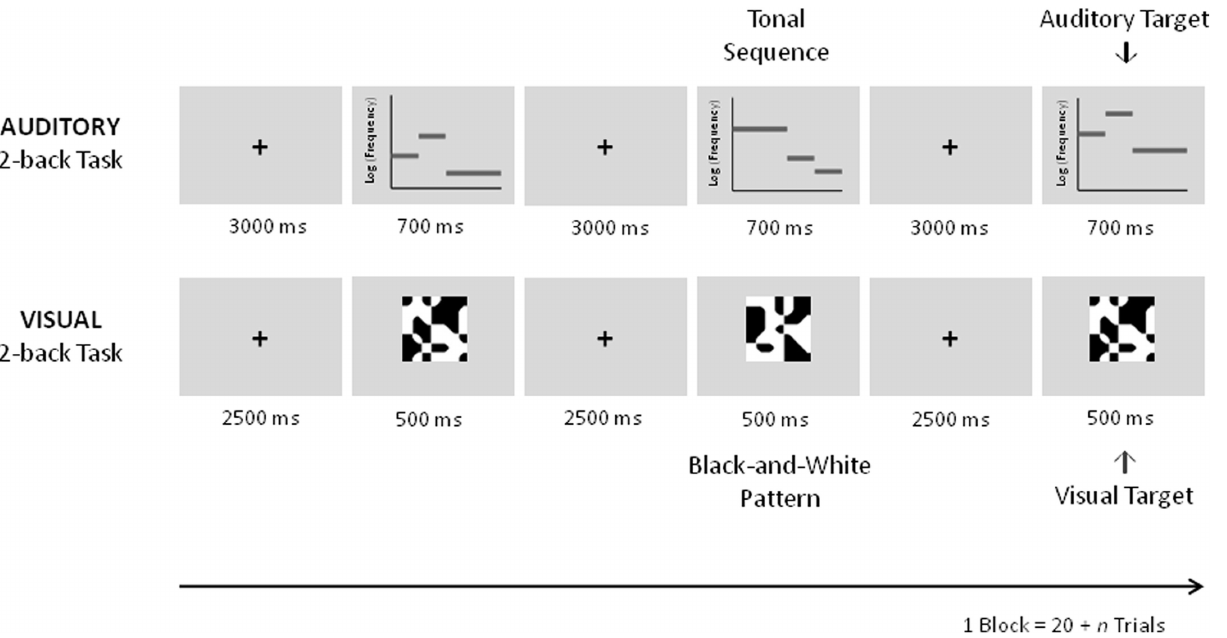
control task) and modality (visual and auditory modality).